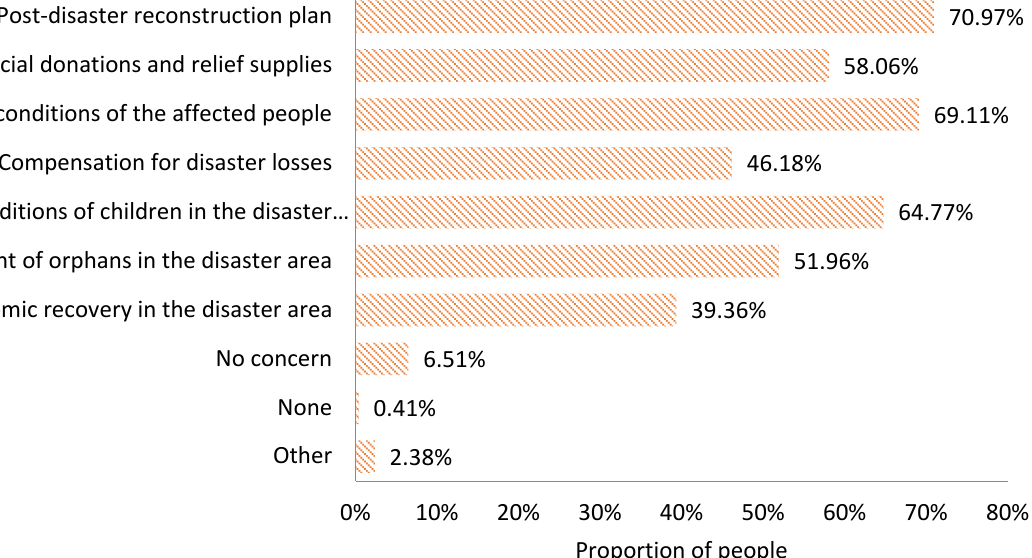
Figure 8. Information expected to be acquired by the public in the resolution stage of an earthquake disaster.